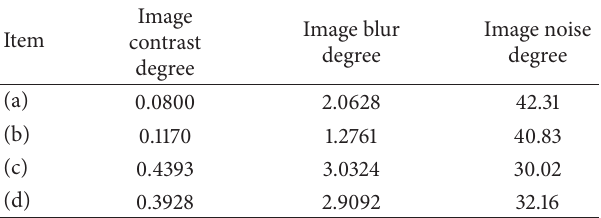
Table 3: The image quality evaluation results of Figure